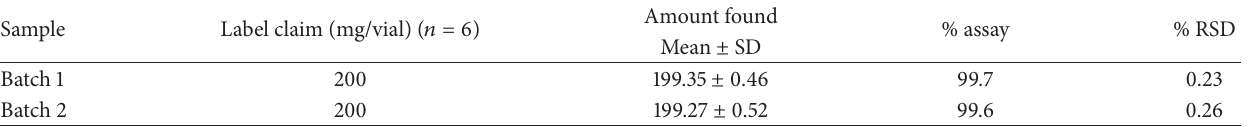
Table 7: Assay of